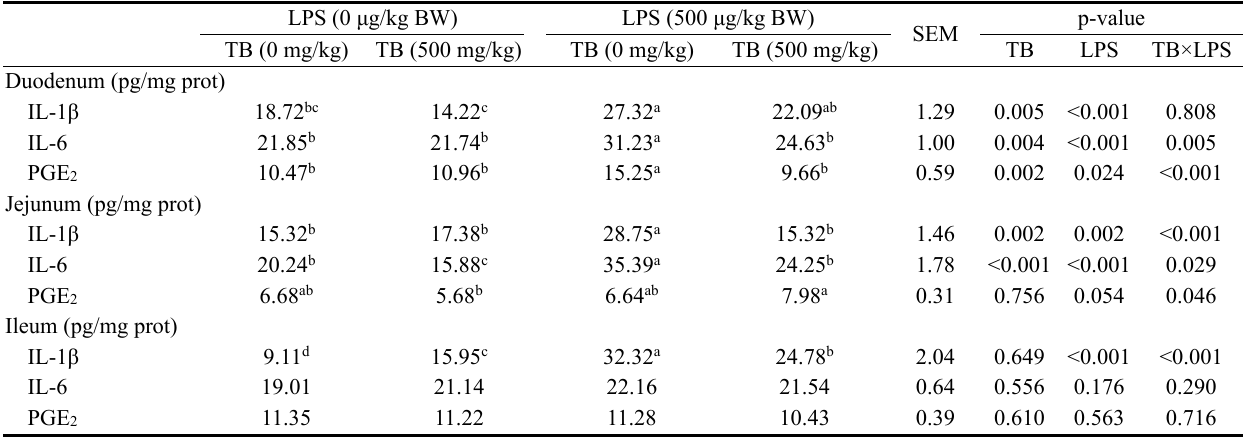
Table 2. Effects of TB on the levels of pro-inflammatory cytokines in intestine of broilers challenged with LPS